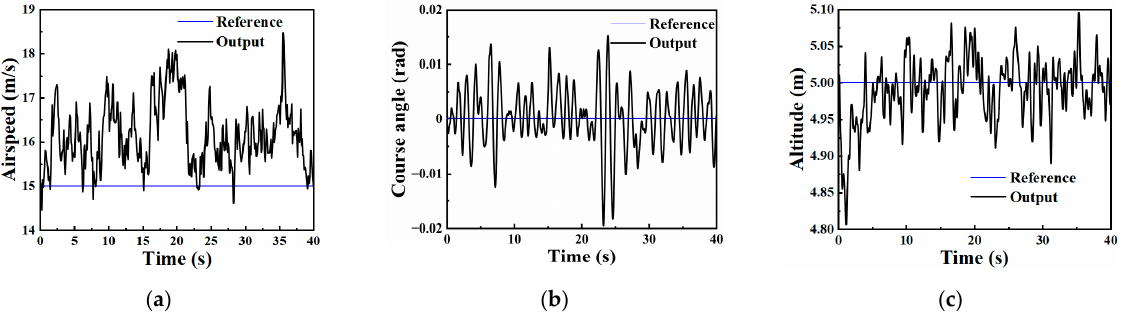
Figure 23. Responses of the UAV under turbulent conditions: ( a ) airspeed; ( b ) course angle; ( c ) altitude.